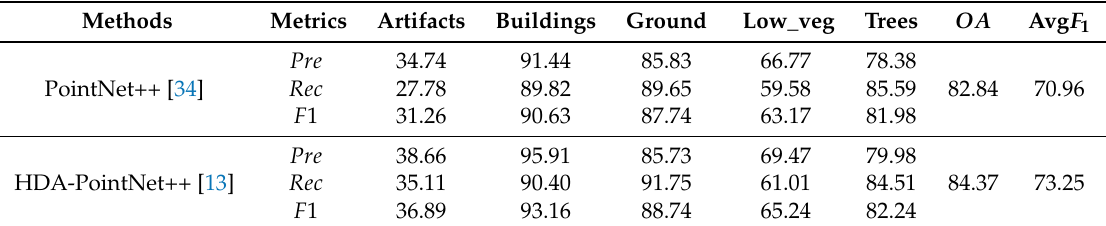
Table 3. Comparison of classification results using the LASDU dataset (with intensities) with different semantic labeling methods (all values are in